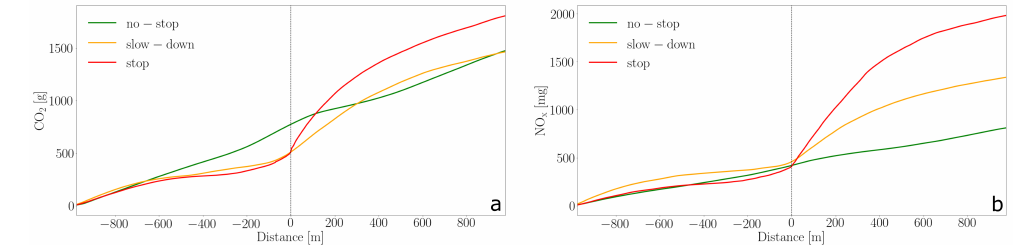
Figure 7. ( a ) Median instantaneous NO x flow for the three groups. Green, amber, and red represent the no-stop, slow-down, and stop groups, respectively. The position is relative to the location of the intersection, as described on OSM. The vertical dashed lines denote the different regions used to group the speed profiles (see Section 2 for further details). ( b ) Results for the NO x flow for the three groups. Green, amber, and red represent the no-stop, slow-down, and stop groups, respectively. Differences between all groups are significant.